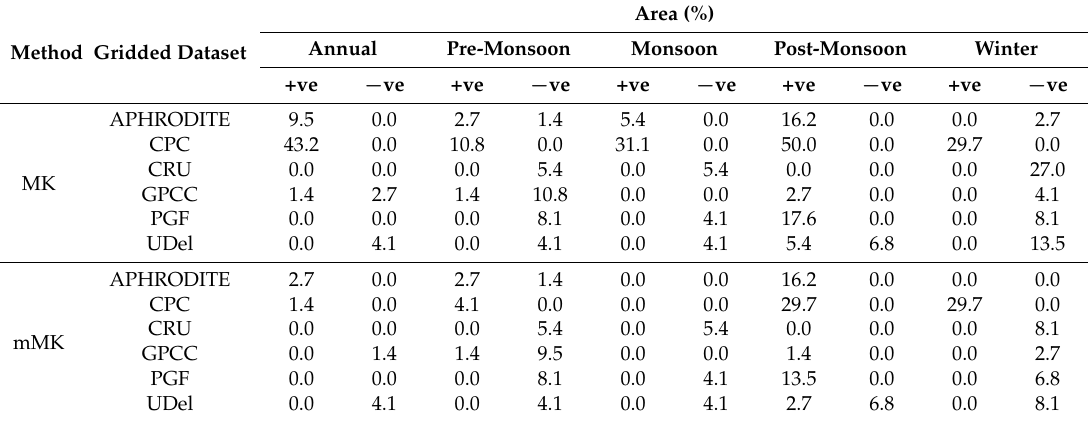
Table 3. Percentage of the area where gridded data showed significant positive (+ve) or negative ( − ve) change in annual and seasonal rainfall using the Mann–Kendall (MK) and modified MK (mMK) tests during